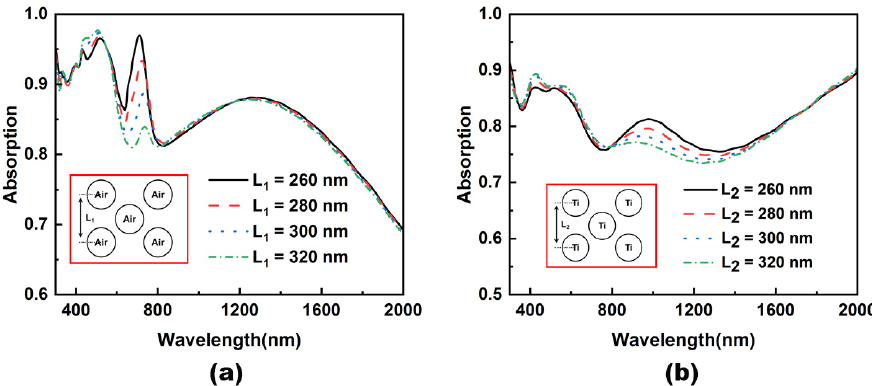
Figure 4. Absorptive spectra change of absorbers with air ( a ) and titanium ( b ) nanopillar arrays as the center distance between nanopillars is changed.